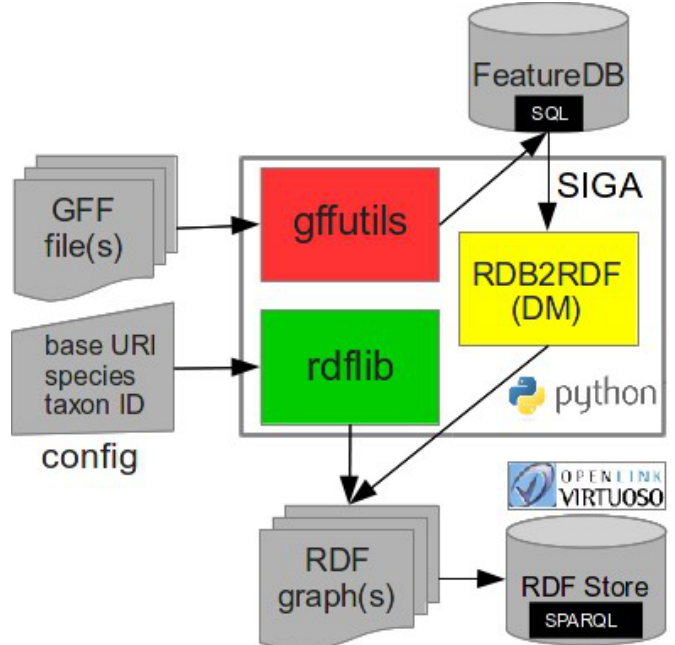
Figure A1. SIGA.py software